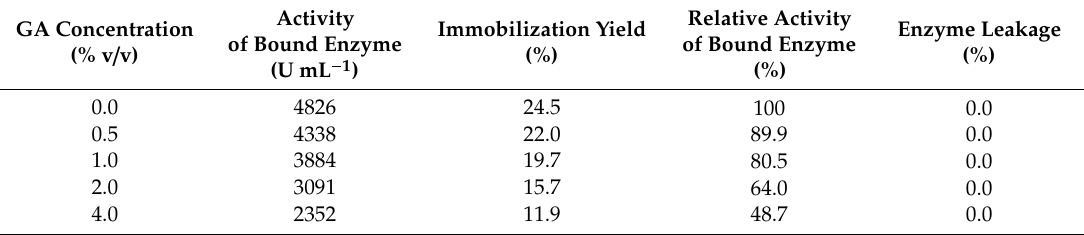
Table 7. E ff ect of the concentration of glutaraldehyde (GA) on invertase immobilization in gelatin-based hydrogel (cross-linking time 10